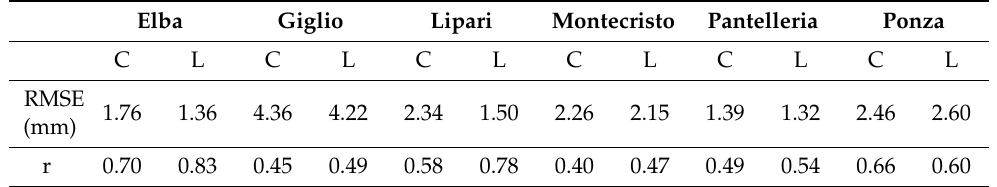
Table 3. RMSE (Root Mean Square Error) and Pearson correlation coefficients for six islands in the central Mediterranean basin around Italy. The statistics are computed considering all the 3 h rainfall forecasts for November 2019 (C is for CTRL; L is for LIGHT). Elba Giglio Lipari Montecristo Pantelleria Ponza